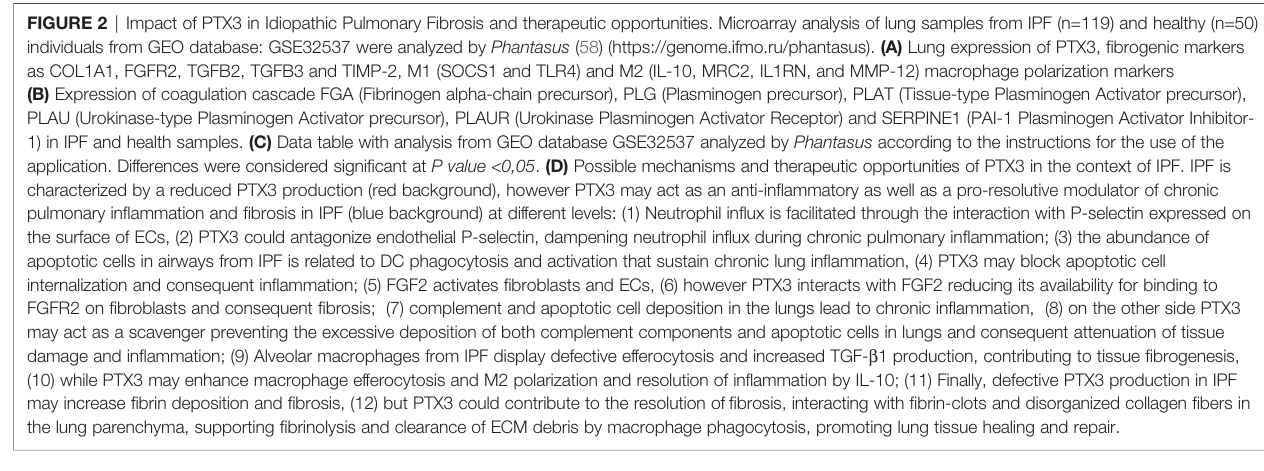
FIGURE 2 | Impact of PTX3 in Idiopathic Pulmonary Fibrosis and therapeutic opportunities. Microarray analysis of lung samples from IPF (n=119) and healthy (n=50) individuals from GEO database: GSE32537 were analyzed by Phantasus (58) (https://genome.ifmo.ru/phantasus). (A) Lung expression of PTX3, fi brogenic markers as COL1A1, FGFR2, TGFB2, TGFB3 and TIMP-2, M1 (SOCS1 and TLR4) and M2 (IL-10, MRC2, IL1RN, and MMP-12) macrophage polarization markers (B) Expression of coagulation cascade FGA (Fibrinogen alpha-chain precursor), PLG (Plasminogen precursor), PLAT (Tissue-type Plasminogen Activator precursor), PLAU (Urokinase-type Plasminogen Activator precursor), PLAUR (Urokinase Plasminogen Activator Receptor) and SERPINE1 (PAI-1 Plasminogen Activator Inhibitor- 1) in IPF and health samples. (C) Data table with analysis from GEO database GSE32537 analyzed by Phantasus according to the instructions for the use of the application. Differences were considered signi fi cant at P value <0,05 . (D) Possible mechanisms and therapeutic opportunities of PTX3 in the context of IPF. IPF is characterized by a reduced PTX3 production (red background), however PTX3 may act as an anti-in fl ammatory as well as a pro-resolutive modulator of chronic pulmonary in fl ammation and fi brosis in IPF (blue background) at different levels: (1) Neutrophil in fl ux is facilitated through the interaction with P-selectin expressed on the surface of ECs, (2) PTX3 could antagonize endothelial P-selectin, dampening neutrophil in fl ux during chronic pulmonary in fl ammation; (3) the abundance of apoptotic cells in airways from IPF is related to DC phagocytosis and activation that sustain chronic lung in fl ammation, (4) PTX3 may block apoptotic cell internalization and consequent in fl ammation; (5) FGF2 activates fi broblasts and ECs, (6) however PTX3 interacts with FGF2 reducing its availability for binding to FGFR2 on fi broblasts and consequent fi brosis; (7) complement and apoptotic cell deposition in the lungs lead to chronic in fl ammation, (8) on the other side PTX3 may act as a scavenger preventing the excessive deposition of both complement components and apoptotic cells in lungs and consequent attenuation of tissue damage and in fl ammation; (9) Alveolar macrophages from IPF display defective efferocytosis and increased TGF- b 1 production, contributing to tissue fi brogenesis, (10) while PTX3 may enhance macrophage efferocytosis and M2 polarization and resolution of in fl ammation by IL-10; (11) Finally, defective PTX3 production in IPF may increase fi brin deposition and fi brosis, (12) but PTX3 could contribute to the resolution of fi brosis, interacting with fi brin-clots and disorganized collagen fi bers in the lung parenchyma, supporting fi brinolysis and clearance of ECM debris by macrophage phagocytosis, promoting lung tissue healing